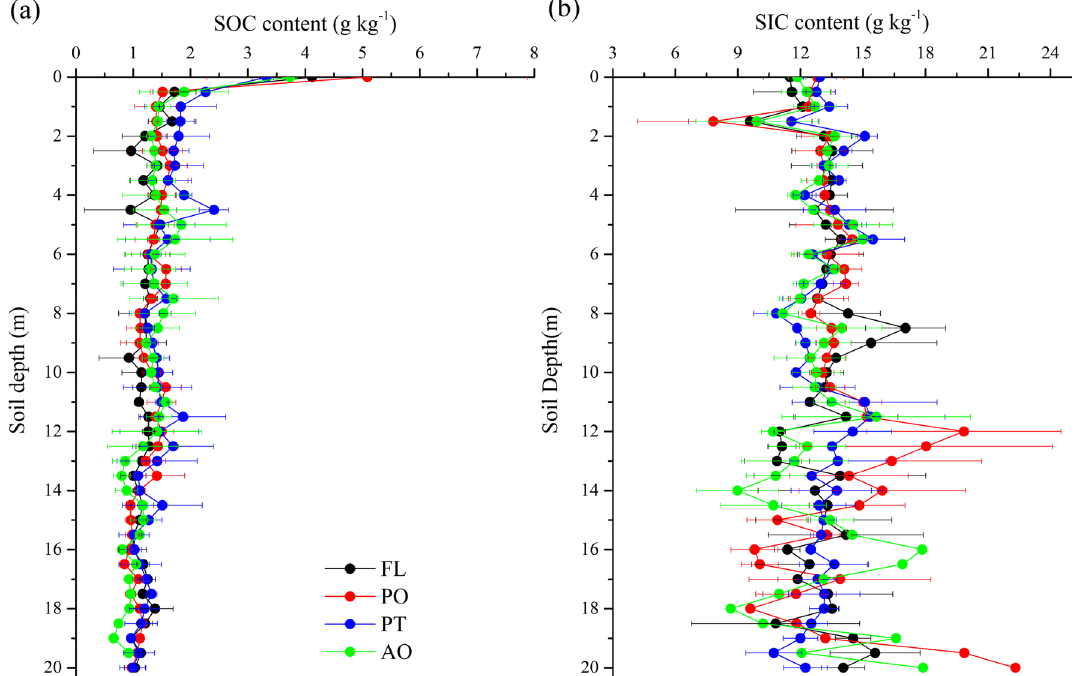
Figure 2. Vertical distributions of SOC and SIC content for different vegetation types. FL farmland, PO Platycladus orientalis (Linn.) Franco, PT Pinus tabulaeformis Carr., AO apple orchard. Bars are standard